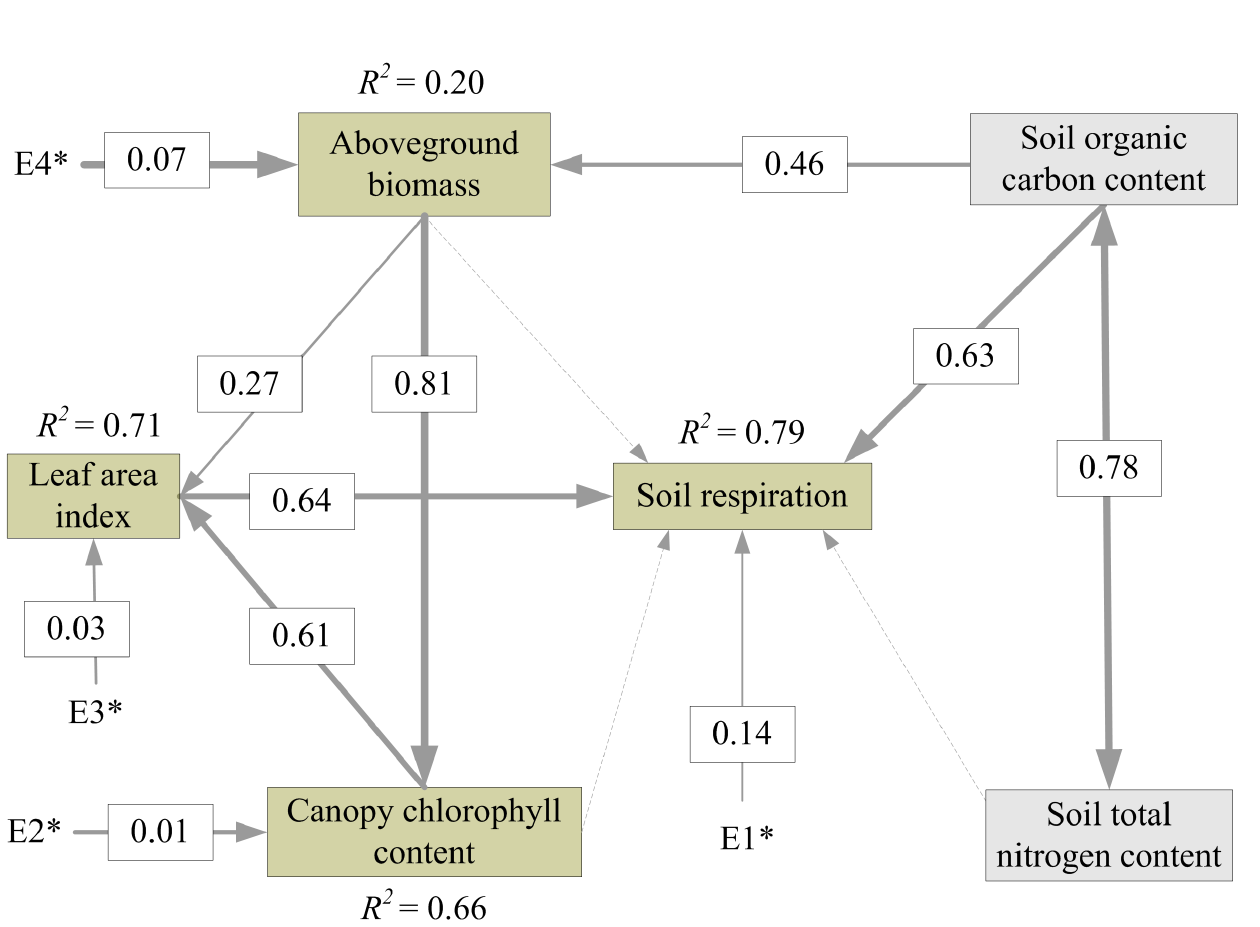
Table 3. Spatial characteristics of soil respiration ( R s , m mol CO 2 m 2 2 s 2 1 ), soil temperature at 10 cm depth (T s10 , u C), soil water content